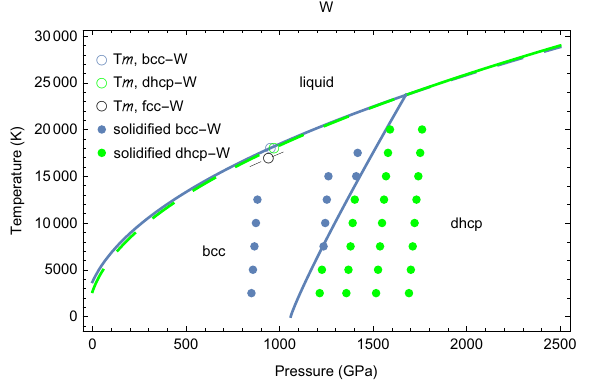
Figure 13. Ab initio phase diagram of tungsten.